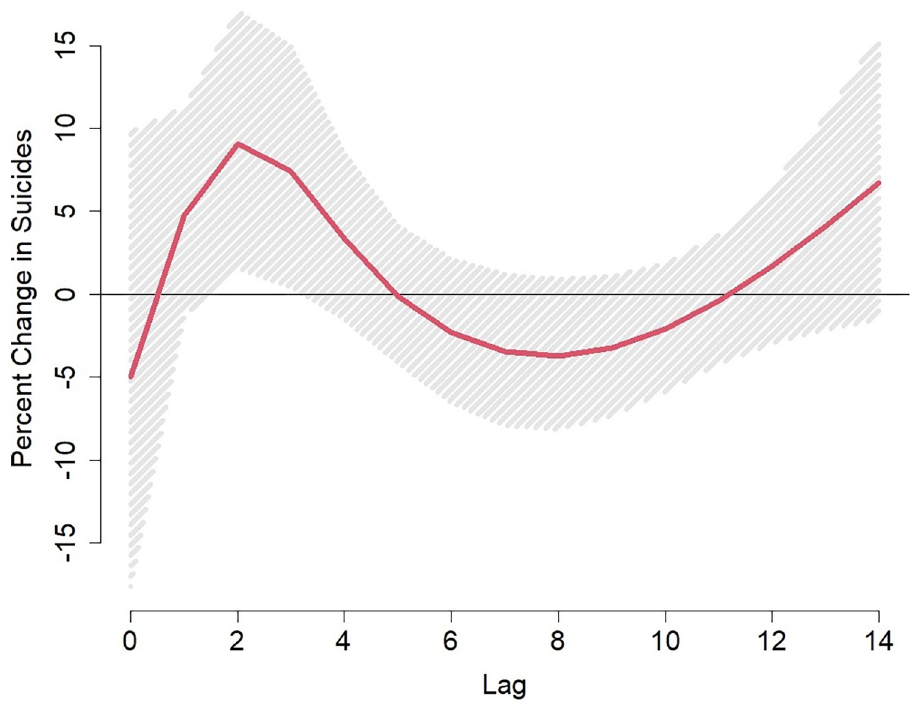
Fig 1. Lag-response curves representing the percent change in total mortality, heart disease-related mortality, and suicides associated with a 10˚F degree increase in mean temperature above the prison-specific summer average at each lag in U.S. prisons between 2001–2019.